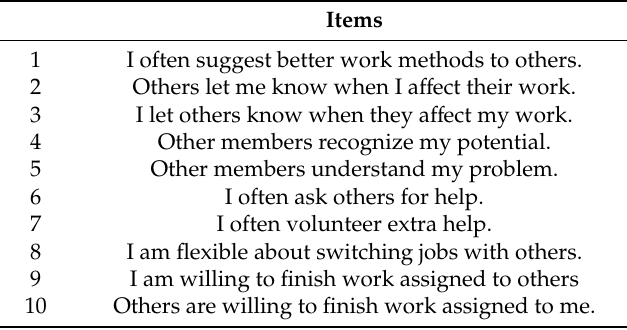
Table 1. Team-member exchange (TMX) scale.